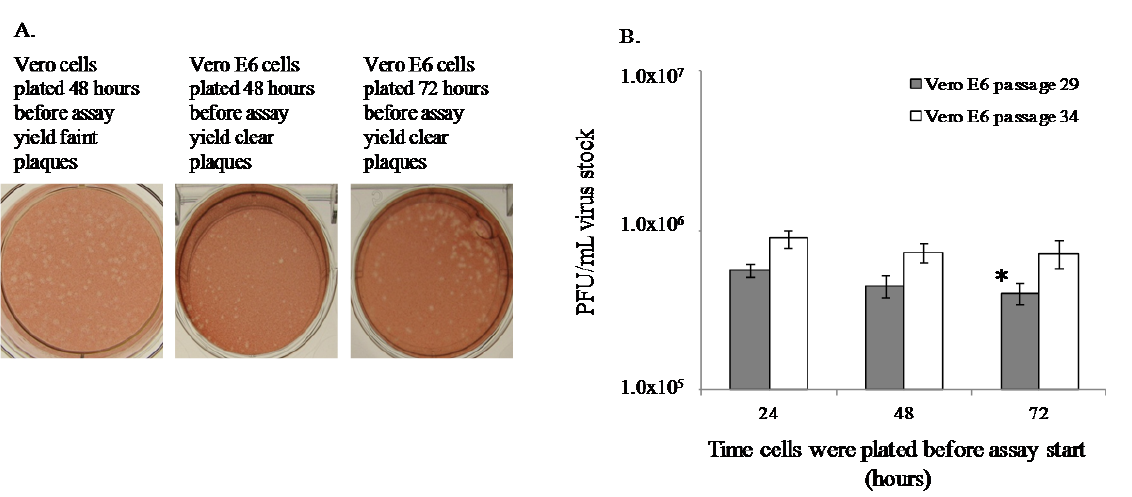
Figure 1. Vero E6 cells are suitable for quantitation of EBOV plaques. ( A ) Vero and Vero E6 cells produce EBOV plaques. ( B ) EBOV titers are similar in ATCC Vero E6 cells plated 24, 48 or 72 hours prior to plaque assay. This experiment was performed twice, and one representative graph is shown. Each bar represents an average of 5 replicates. The * indicates p = 0.006 between 24 and 72 hour samples for passage